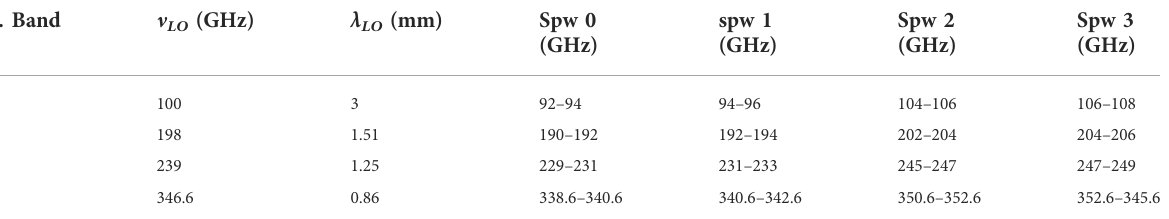
TABLE 1 ALMA solar observing